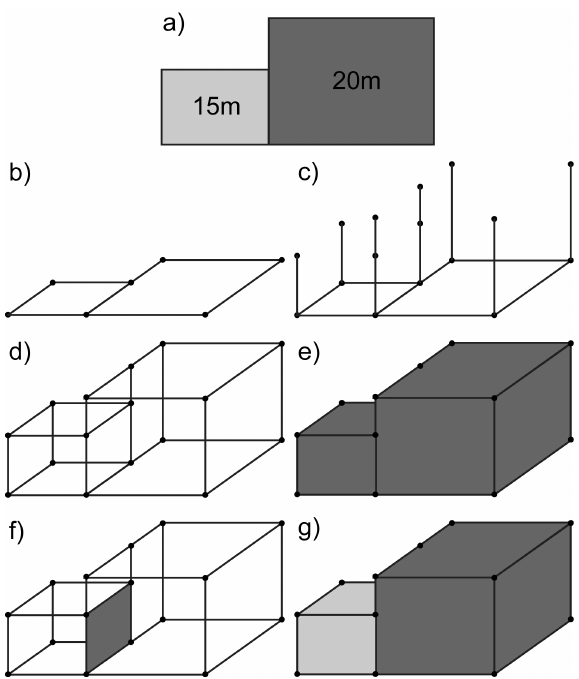
Figure 5. Building extrusion from a footprint: a) the